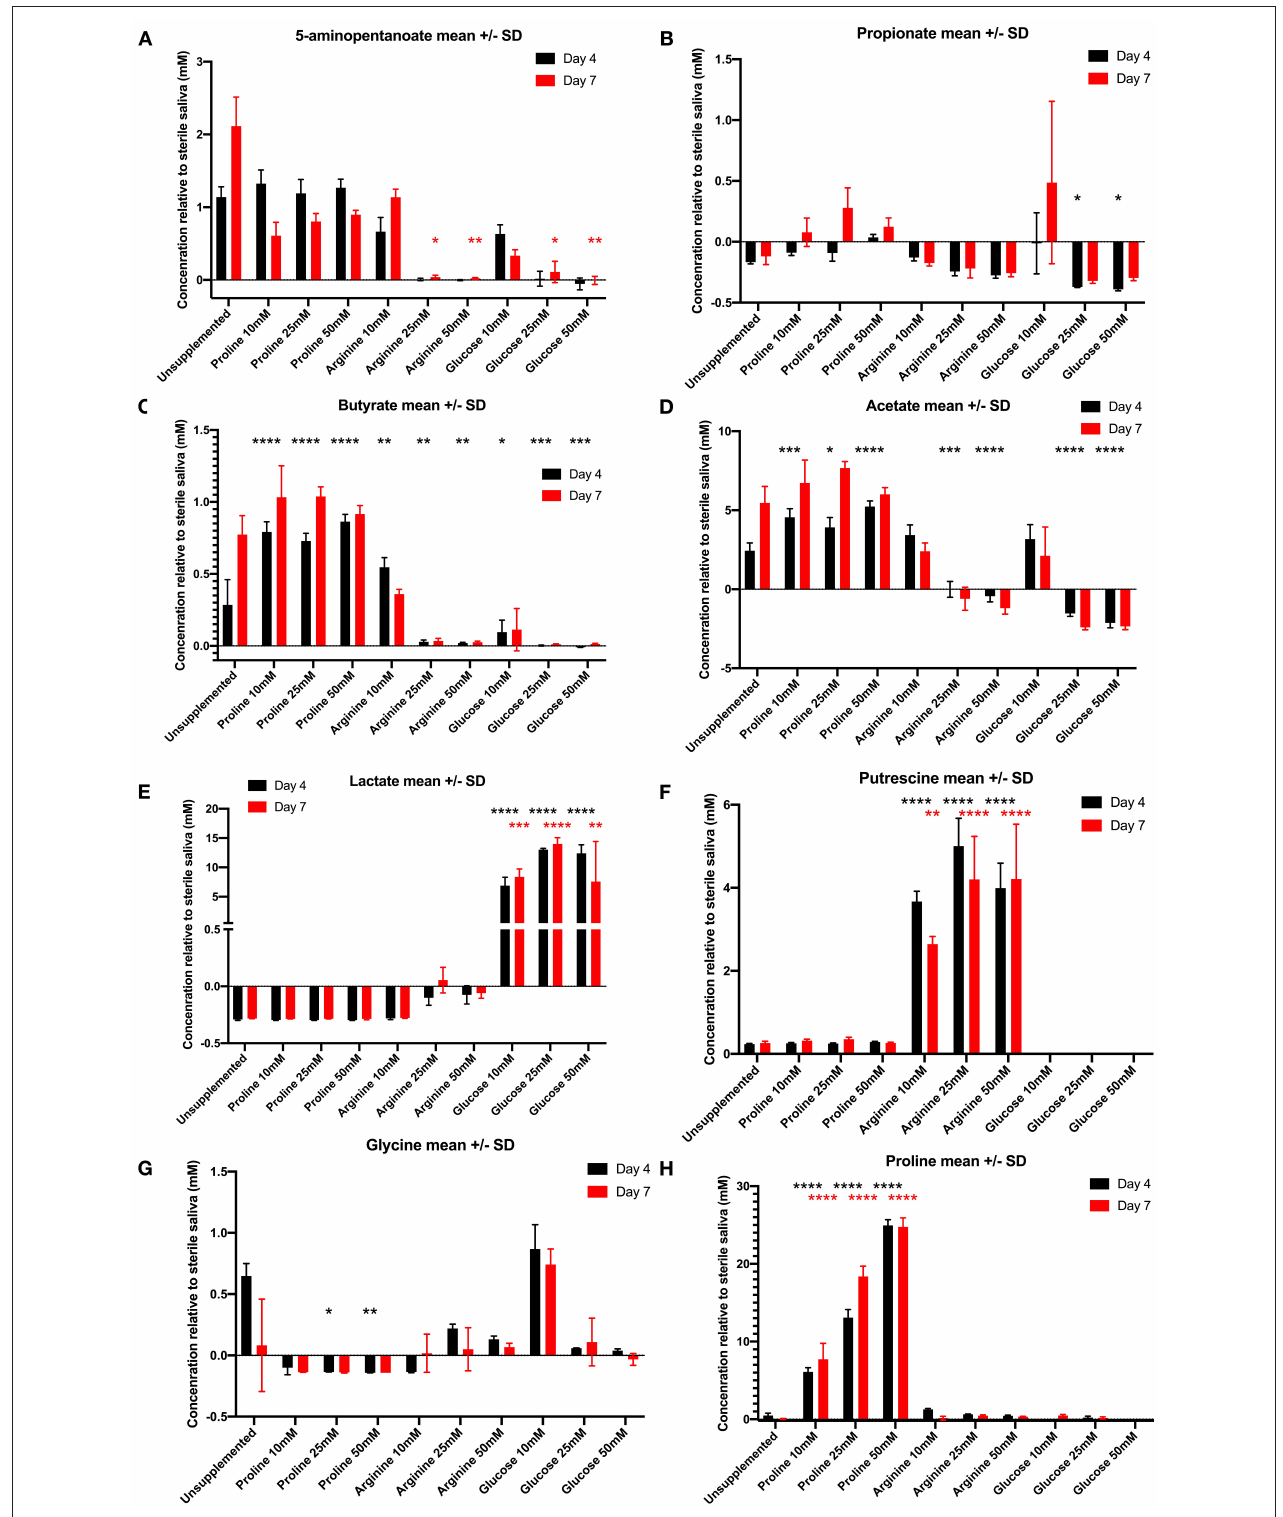
FIGURE 3 | Concentration of metabolites (mean ± standard deviation) in day 4 (black bars) and day 7 (red bars) in unsupplemented and supplemented biofilms relative to the sterile saliva media. Negative concentrations (less than zero) indicate the metabolite has been consumed from the sterile saliva growth medium by bacteria in biofilms. (A) 5-aminopentanoate, (B) propionate, (C) butyrate, (D) acetate, (E) lactate, (F) putrescine, (G) glycine, (H) proline ( n = 3; * p < 0.05, ** p < 0.005, *** p < 0.0005, **** p < 0.0001).